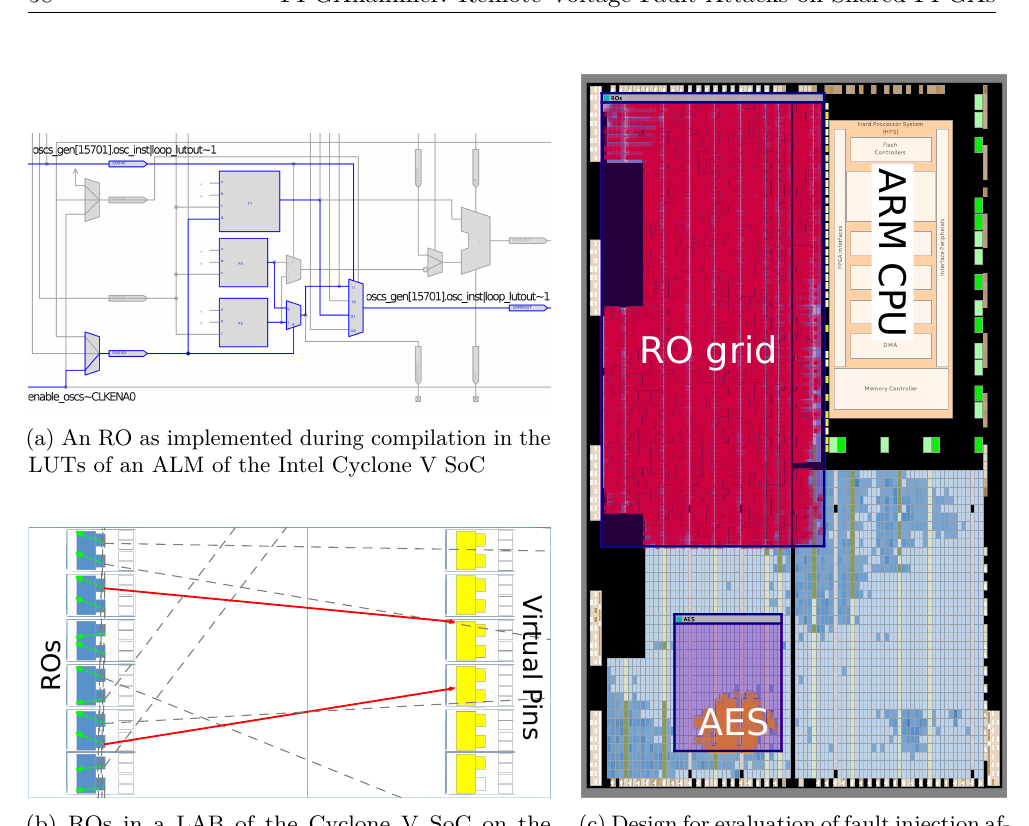
Figure 10: Implementation details of the RO attack design on the Intel Cyclone V SoC as displayed in the Quartus Chip